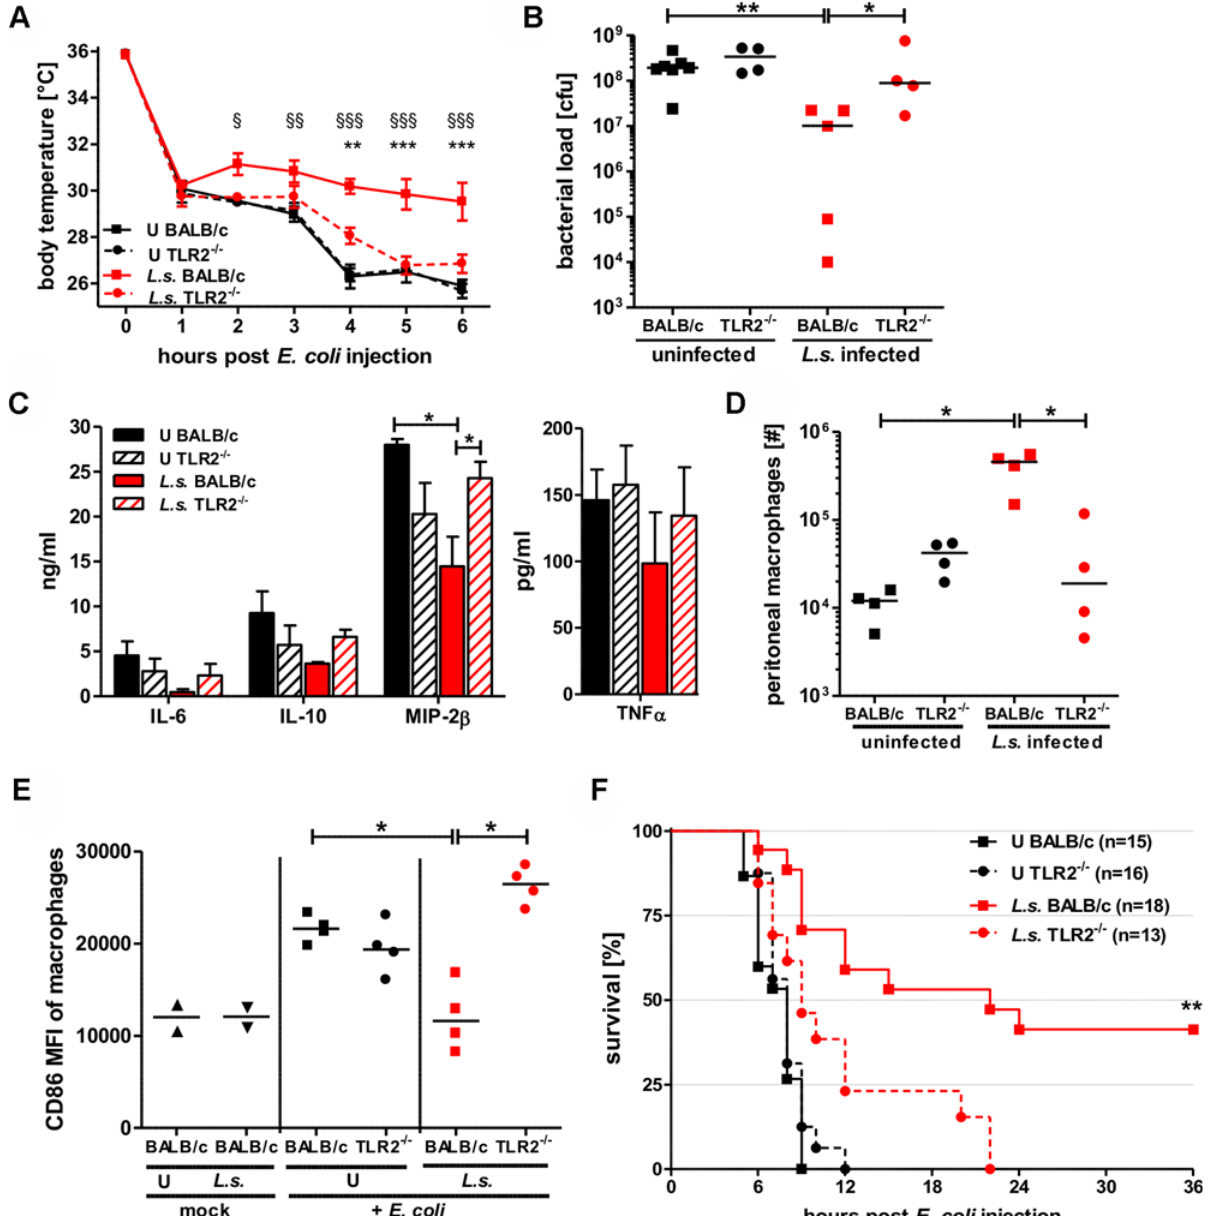
Figure 6. TLR2 is required for mediating protection against E. coli -induced sepsis in filarial-infected mice. ( A ) Kinetic of body temperature in response to i.p. E. coli injection of uninfected (U) and chronic L. sigmodontis ( L.s. )-infected wild type and TLR2-deficient mice. ( B ) Peritoneal bacterial load, ( C ) serum concentrations of IL-6, IL-10, and MIP-2 β , and TNF α , ( D ) total peritoneal F4/80 hi macrophage numbers and ( E ) their mean fluorescence intensity (MFI) of CD86 six hours post E. coli injection. ( F ) Survival after i.p. injection of E. coli into uninfected and L.s. -infected wild type (U: n = 15; L.s. : n = 18) and TLR2-deficient mice (U: n = 16; L.s. : n = 13). ( A-D ) shows a representative dataset from one of two independent experiments with at least 4 mice per group. Data shown in ( A ) is displayed as mean +/- SEM and was tested for statistical significance by 2-way ANOVA and Bonferroni post-hoc test (paragraphs indicate significant differences between L.s. -infected and uninfected wild type mice and asterisks in comparison to L.s. -infected TLR2 -/- mice). Data shown in ( B-E ) was tested for statistical significance by 1-way ANOVA followed by Dunn ’ s post-hoc test. ( F ) Pooled data from two independent experiments. Differences between L.s. -infected BALB/c and TLR2 -/- mice were tested for statistical significance by Mantel-Cox Log-rank test (p = 0.0035). * p < 0.05; ** p < 0.01; *** p < 0.001.